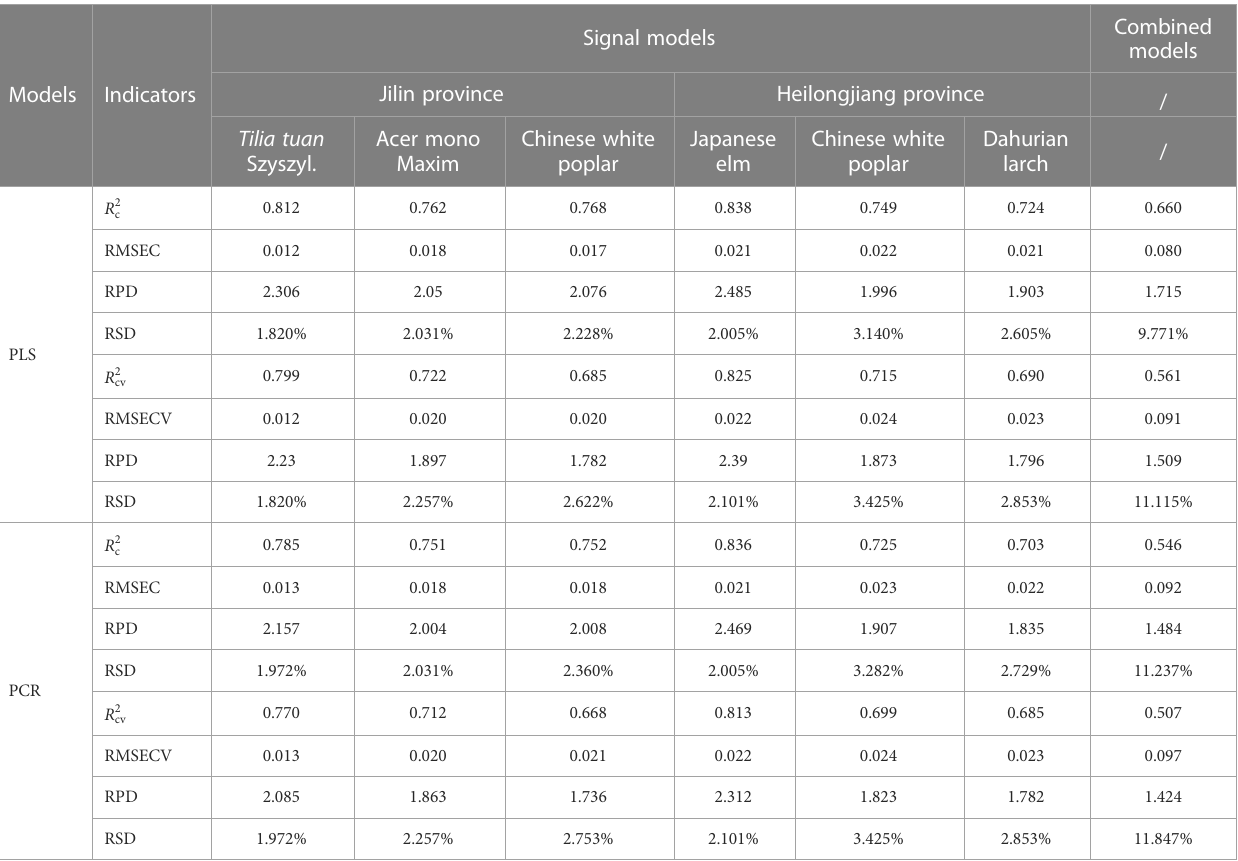
TABLE 5 The results of PLS and PCR signal and combined models for various tree species.